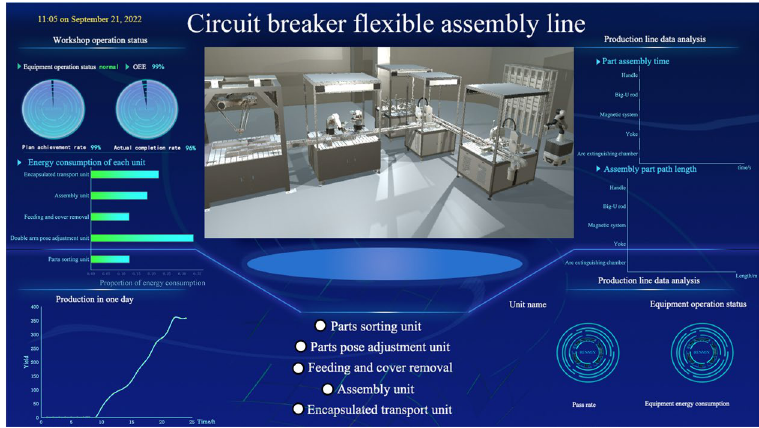
Figure 26. Main interface of DT system of multi-robot cooperative CBFMS.